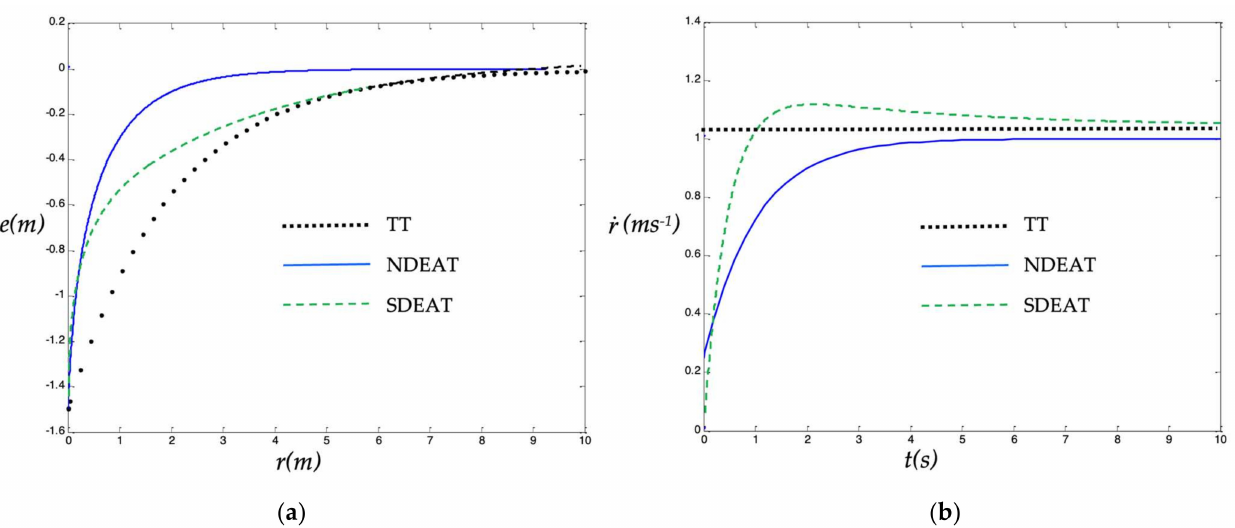
Figure 3. ( a ) TT, NDEAT and SDEAT transient behaviors for a big initial error. ( b )